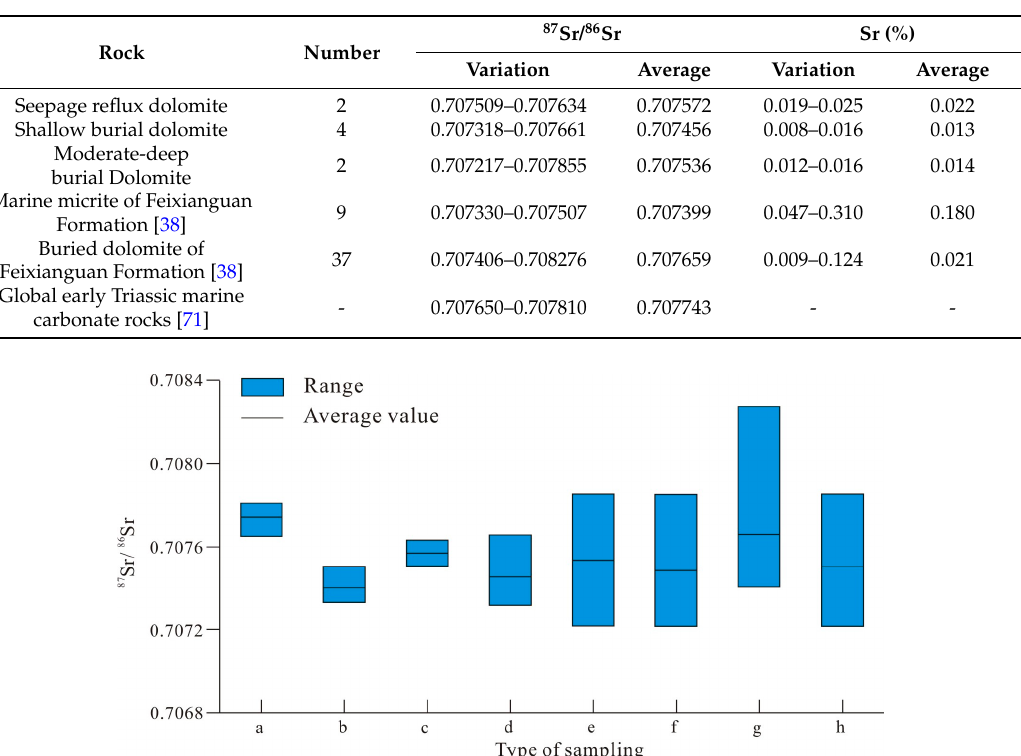
Figure 9. Strontium isotope features of various carbonate rocks of the Feixianguan Formation: (a) Global early triassic marine carbonates [71]. (b) Marine microcrystalline limestone from the Feixianguan Formation [38]. (c) Seepage reflux dolomites from this study. (d) Shallow burial dolomites from this study. (e) Middle-to-deep burial dolomite from this study. (f) All burial dolomite from this study. (g) Group of burial Feixianguan dolomites [38]. (h) All the dolomite samples from this study.